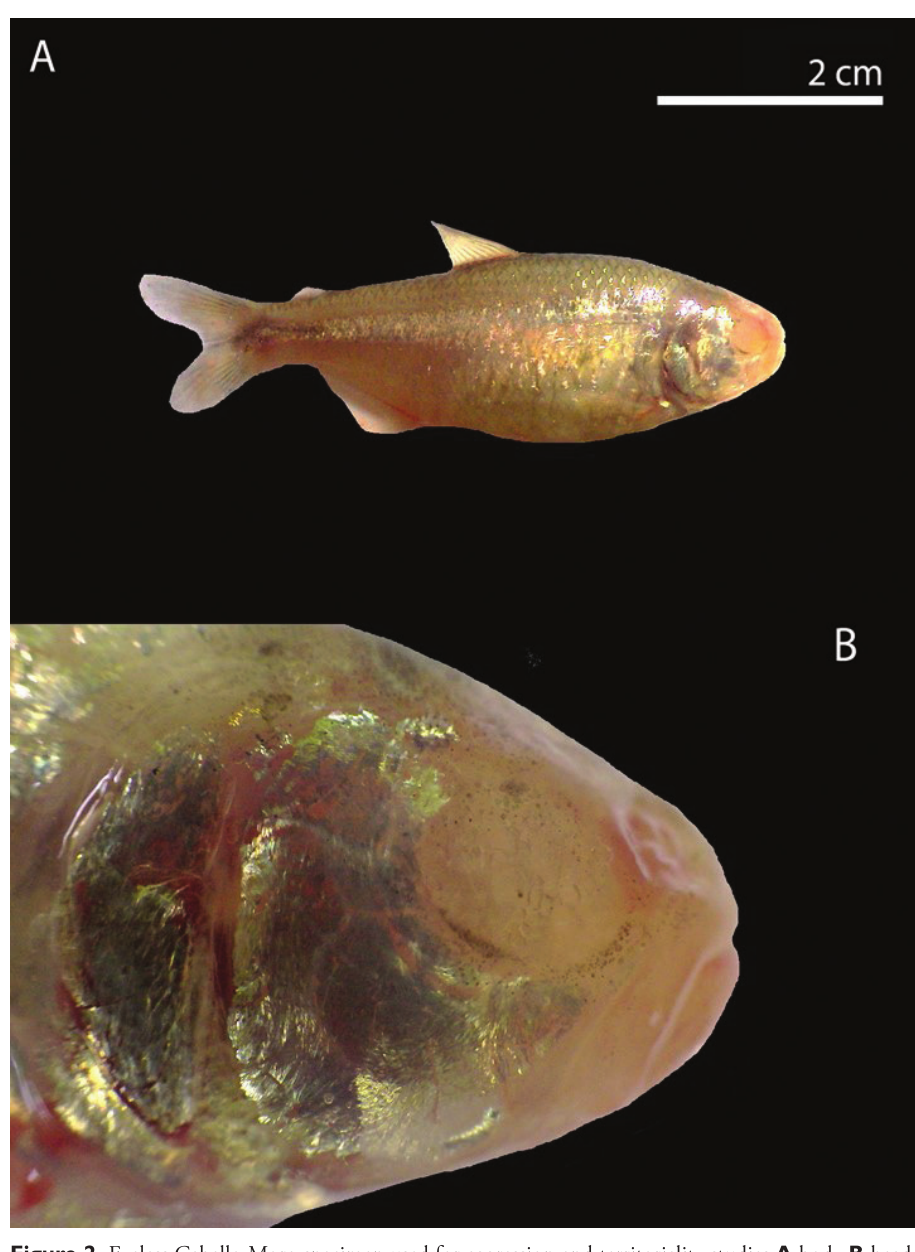
Figure 2. Eyeless Caballo Moro specimen used for aggression and territoriality studies A body B head. While the Caballo Moro cave is inhabited by both the eyed and the eyeless morphs, only eyeless specimens were used in this study. The other populations used in this study; Molino, Jineo, Vásquez, Escondido, Pachón and Tinaja caves are inhabited exclusively by eyeless